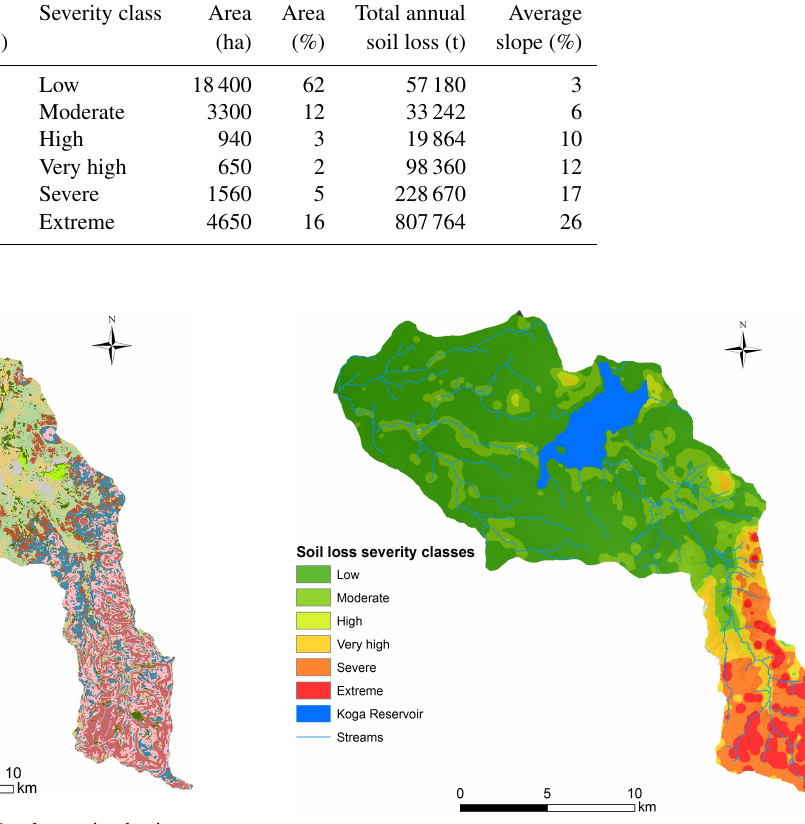
Figure 7. Spatial distribution of calculated P values using basing on